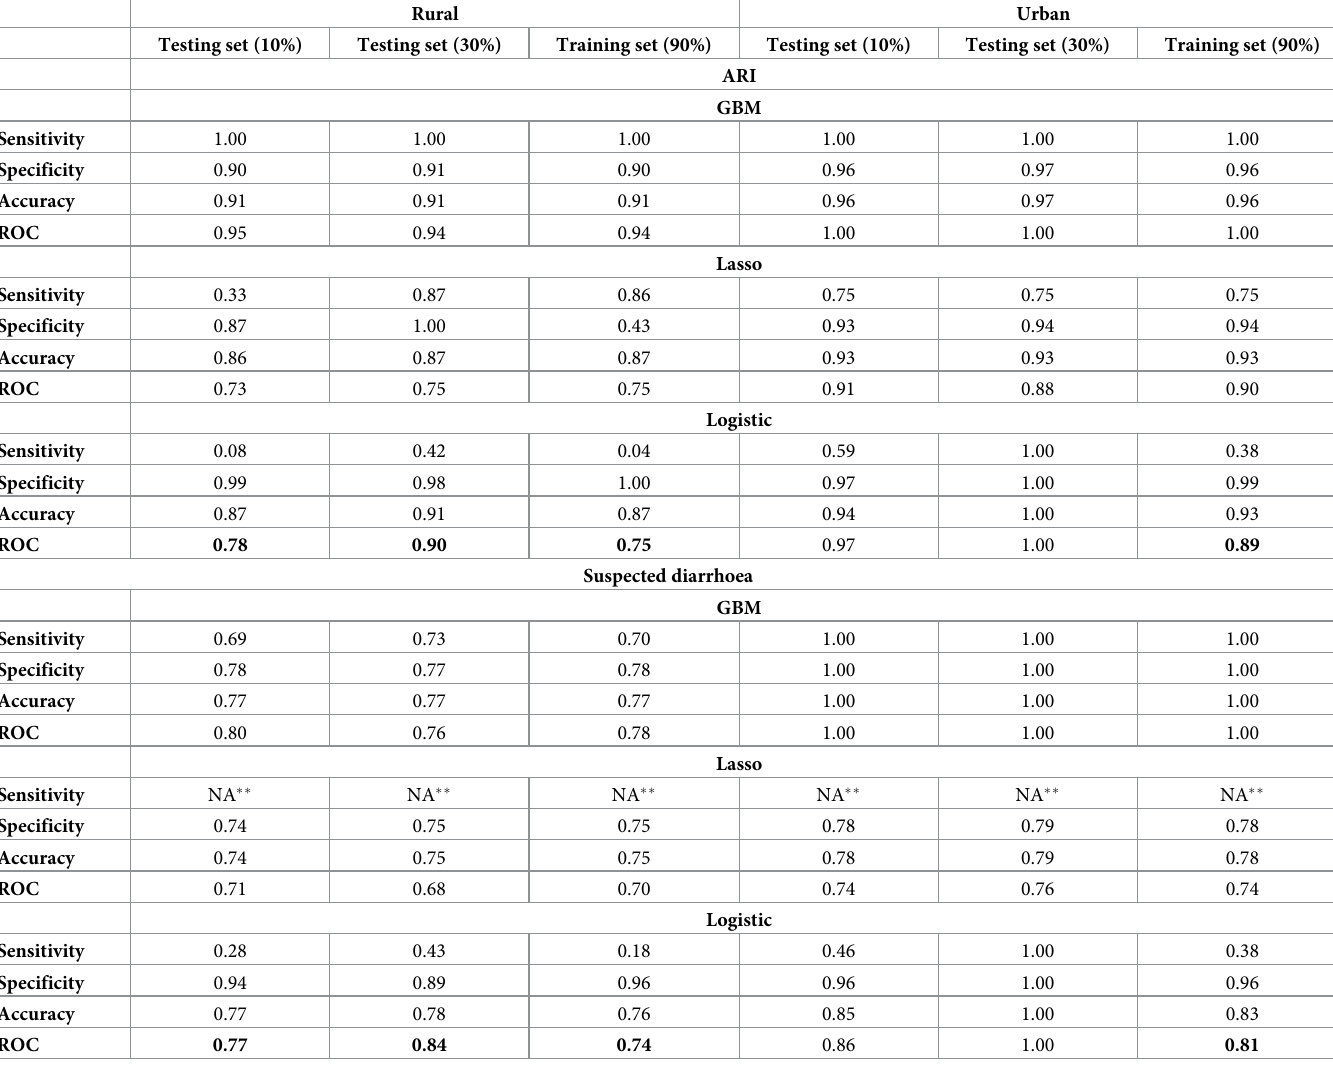
Table 3. Comparing the performance of logistic, Lasso and GBM models in the identification of the predictors of ARI and diarrhea. Rural Urban Testing set (10%) Testing set (30%)